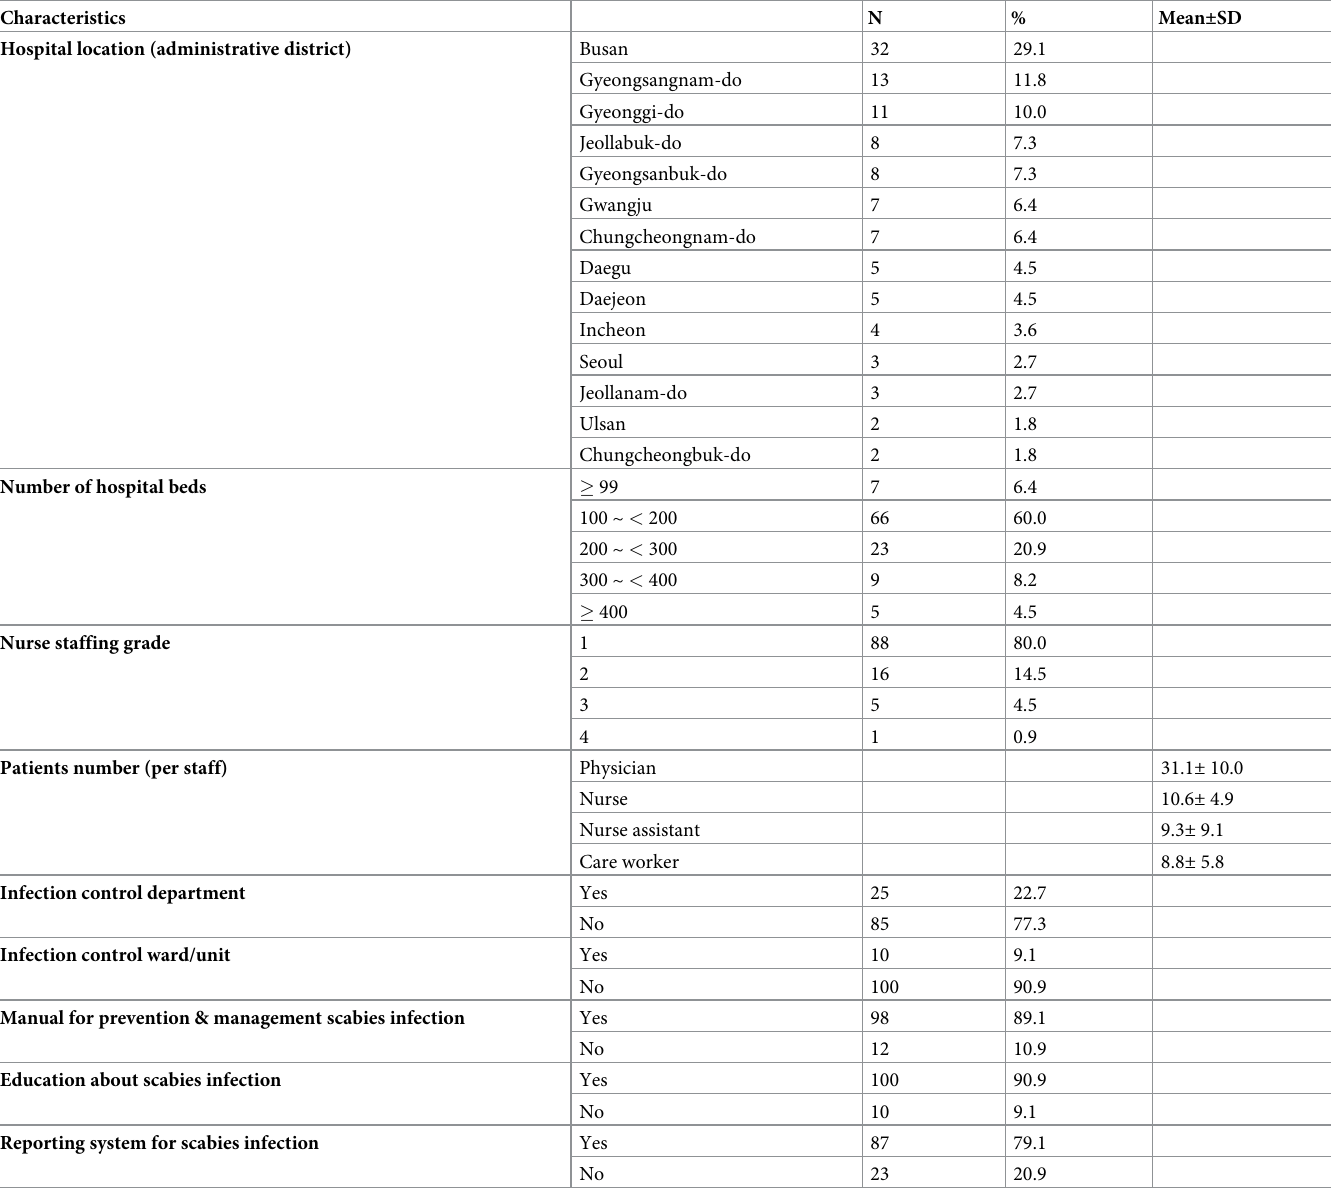
Table 1. Characteristics of the participants (N =